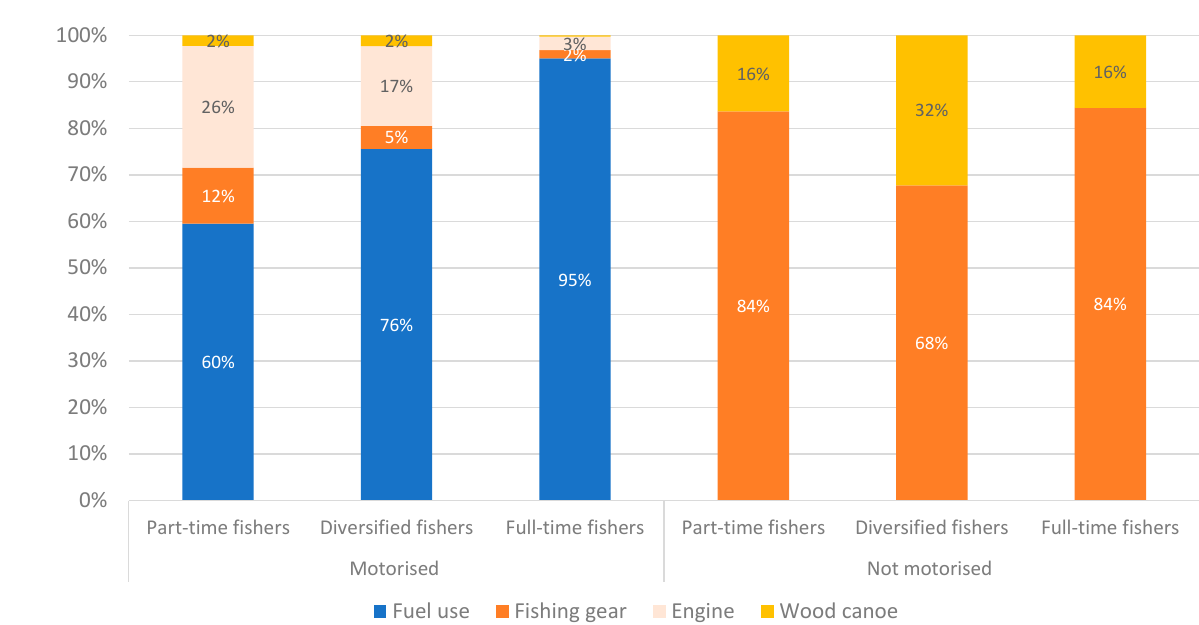
Figure 4. Contribution analysis of Malian fresh fish products per type of fisher, per t of product, relative to the single score, of those ( a ) non-segregated by motorisation and ( b ) segregated by motorisation.